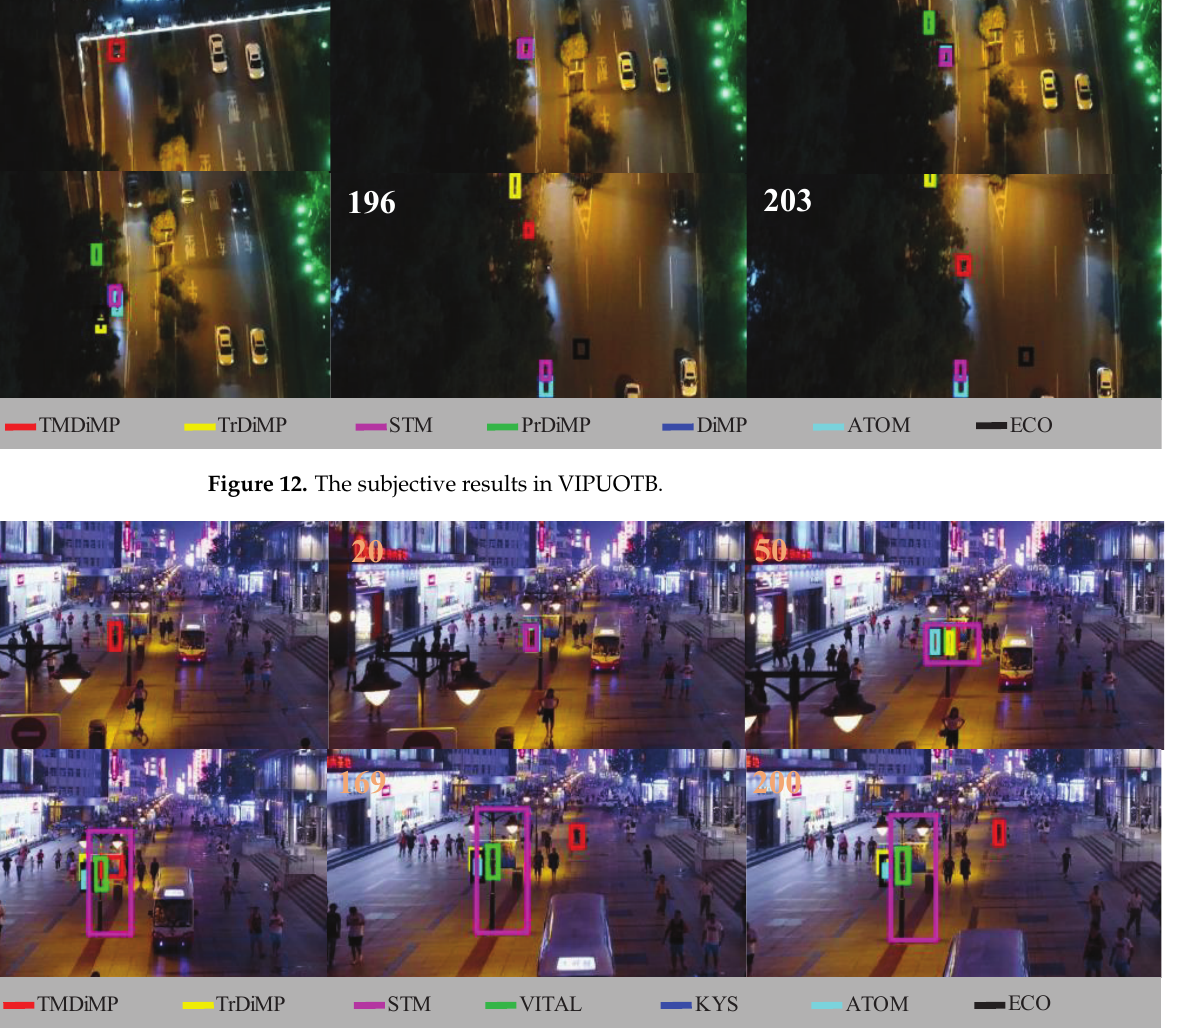
Figure 13. The subjective results in